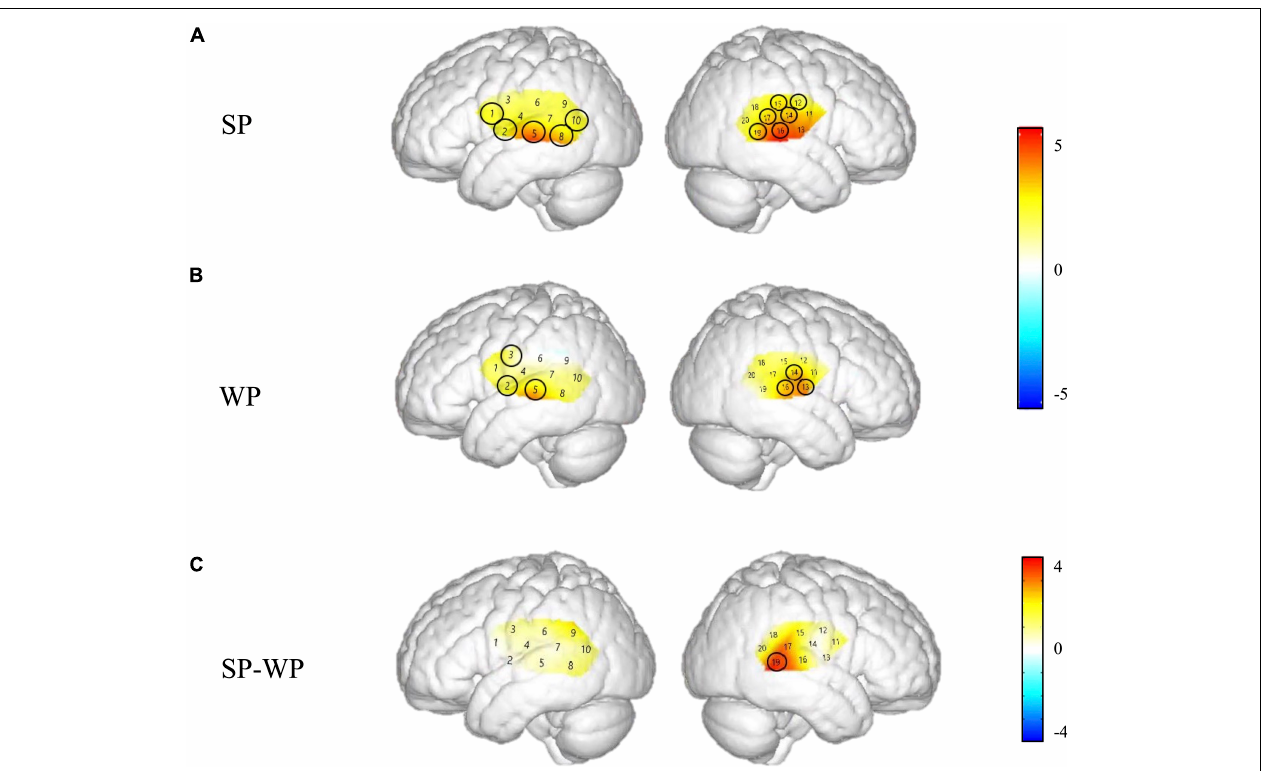
FIGURE 4 | Cortical activation maps of the normal hearing (NH) group on the normalized brain surface. The color scales represent the T values, with statistically significant activated channels circled in black [ p FRD - cor < 0.05]. (A,B) Lateral views of significantly activated channels under strong-prosodic (SP) and weak-prosodic (WP) conditions contrasted against silence, respectively. (C) Lateral views of significantly activated channels by contrasting between conditions, indicating the stronger activated neural areas driven by the SP features in SP